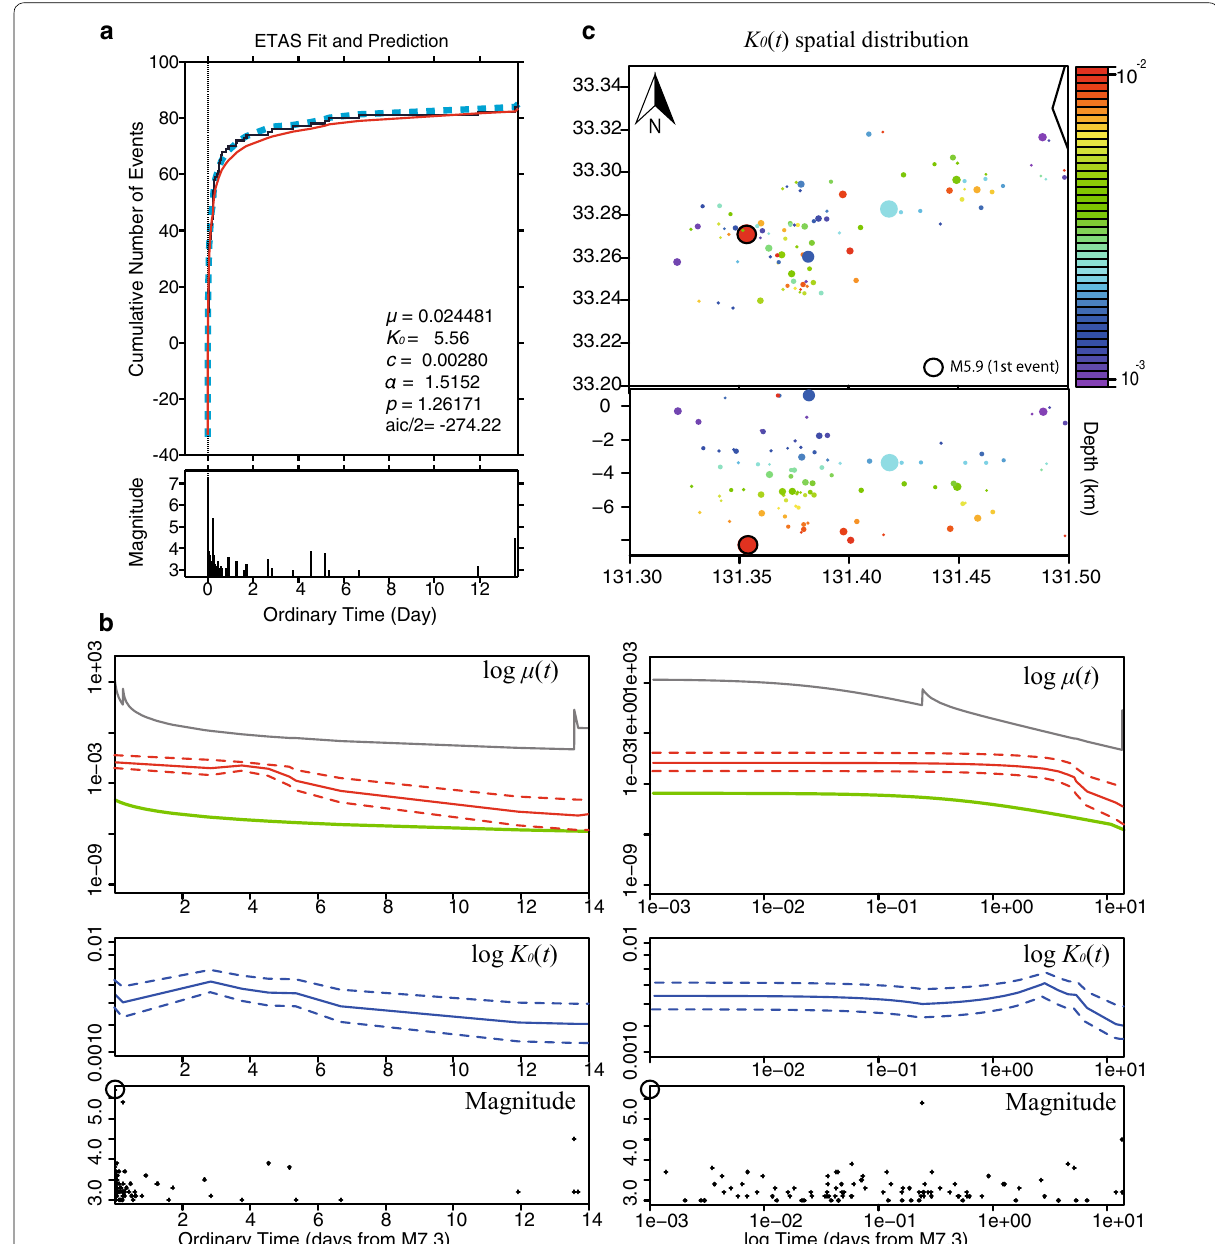
Fig. 9 Non-stationary ETAS model and model (2) applied to the Oita subregion (S3 in Fig. 6a). The marks, line types, and colors are the same as indicated in Fig. 7, except that the thick green curve represents the triggering effect of the M7.3 mainshock indicated by the third term in model (2)